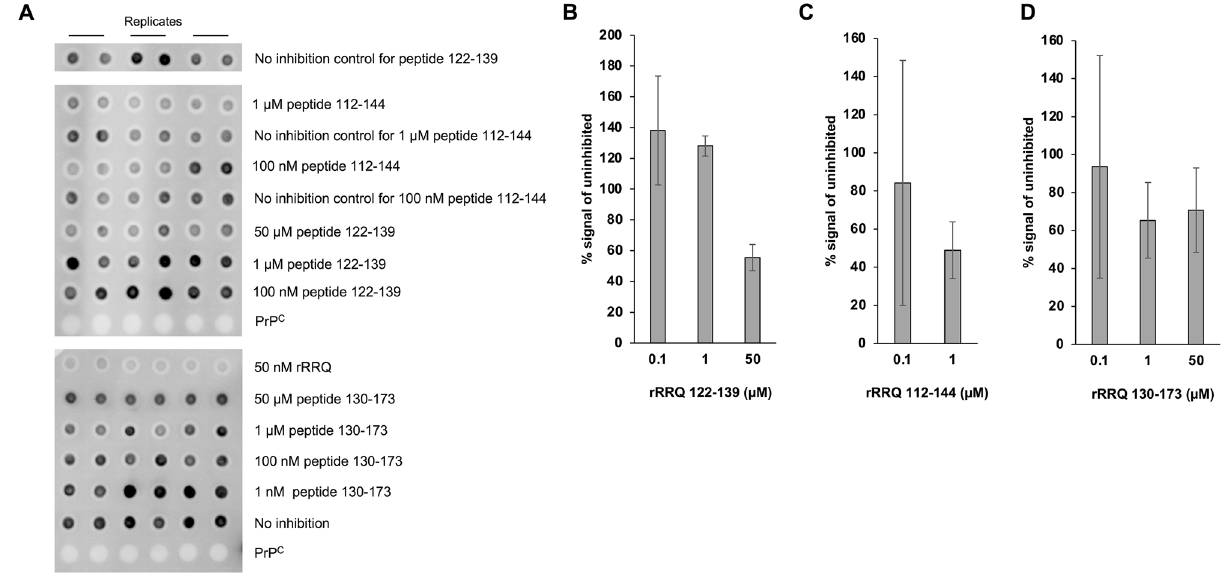
Figure 3. Prion replication inhibition with peptides of rRRQ spanning residue 136. PMCA amplification of scrapie VRQ/ARQ prion in a VRQ/VRQ substrate was carried out in the absence or presence of a rRRQ peptides (all in triplicate) and analysed by dot blot (each sample in duplicate). Peptides were composed of amino acid residues 122–139 (added at 100 nM to 50 μM, ( A and B ), 112–144 (100 nM or 1 μM, A and C ) or 130–173 (1 nM to 50 μM as indicated, A and D ). For peptide 112–144 the no inhibition control was carried out in the equivalent dilution of the peptide carrier solvent, 80% (v/v) acetonitrile. All other no inhibition controls were in PBS as the peptides were dissolved in water. Dot blot images ( A ), the top 2 panels are from the same blot (see Figure S3 for the full blot); the bottom panel is from a different blot) were analysed by densitometry to calculate the average signal compared to the corresponding no inhibition control (SD values are also shown for each PMCA triplicate; ( B , C , D ). Data was analysed using one-way ANOVA (with either Dunnett’s multiple comparison test for peptide 122–139 or 139–173, or Šidák’s multiple comparison test for peptide 112–139) at the concentrations used versus the relevant no inhibition control. No significant inhibition was seen for peptides at the concentrations tested. PrP C , brain PMCA substrate used as a PK-digestion